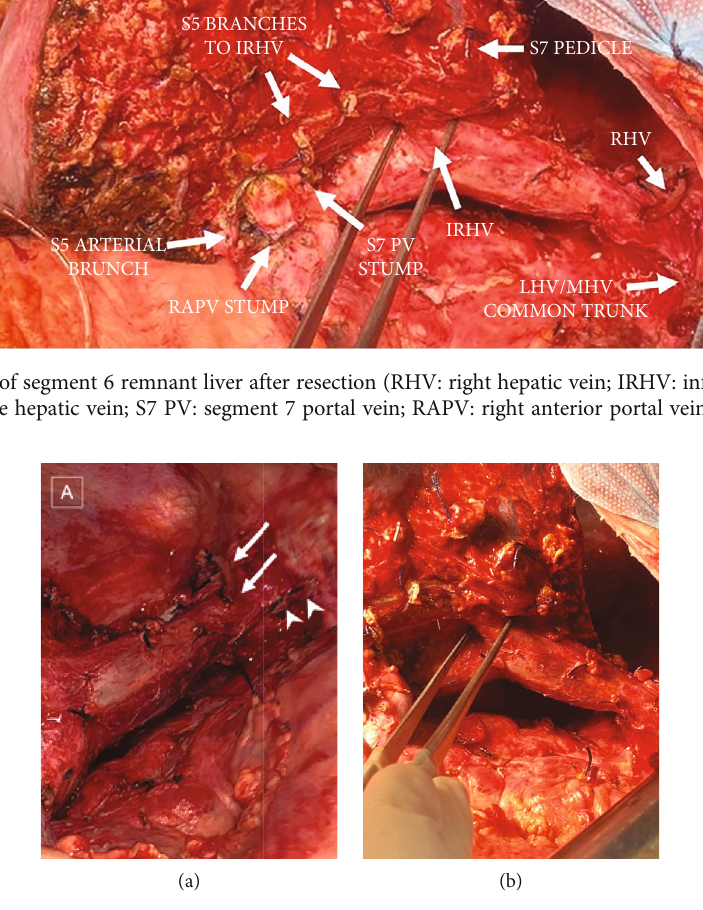
Figure 4: Surgery details — intraoperative view. (a) Inferior vena cava with RHV (arrows) and common trunk of MHV and LHV (arrowheads) divided by vascular stapler. (b) IRHV between